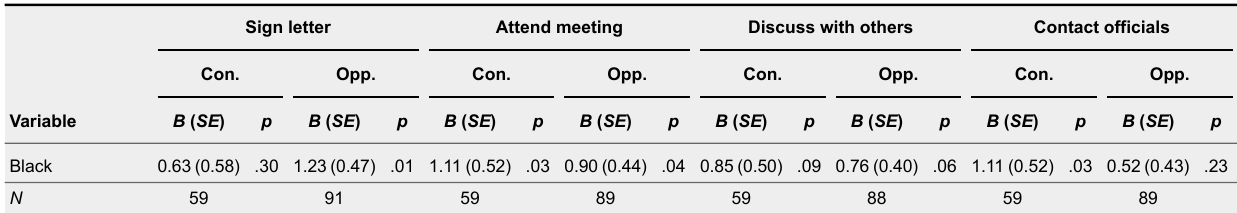
Logit Models Regressing Race on Participant's Likelihood of Taking Action on DWSD, Across Control and Opportunity Conditions